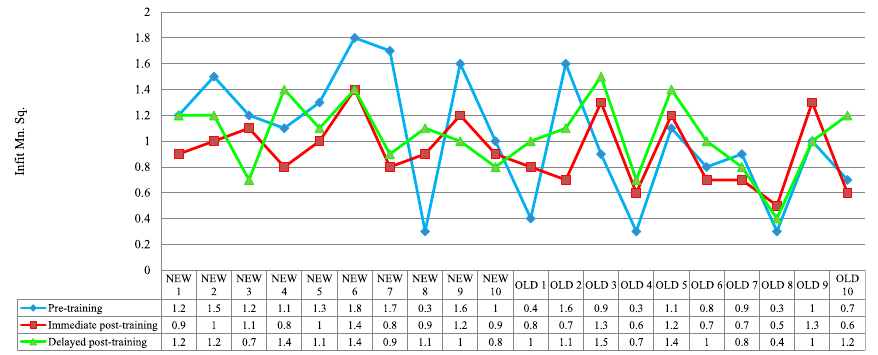
Fig. 10 Raters’ rating consistency measures in the three phases of the study